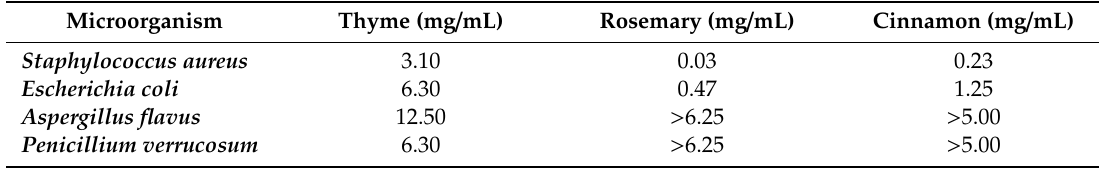
Table 1. Minimum inhibitory concentrations (MICs) of thyme, rosemary and cinnamon extracts determined by microdilution